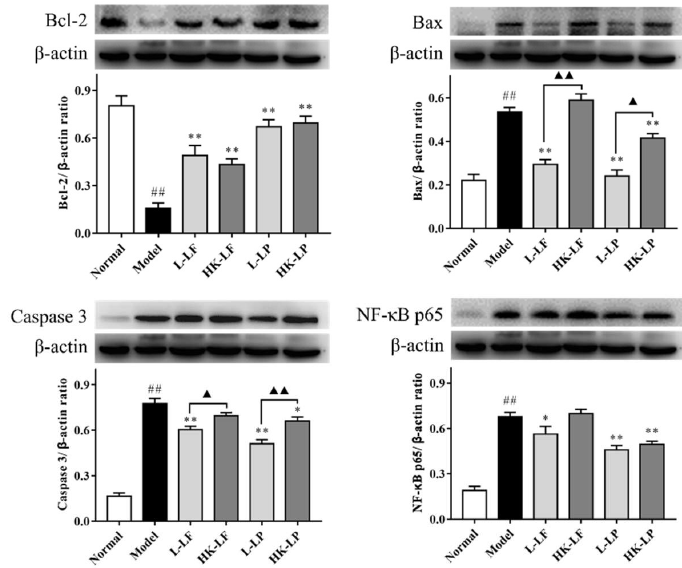
Figure 8. Related protein levels in liver injury. ## p < 0.01 compared with the normal group, * p < 0.05, ** p < 0.01 compared with the model group, ▲ p < 0.05 and ▲▲ p < 0.01.